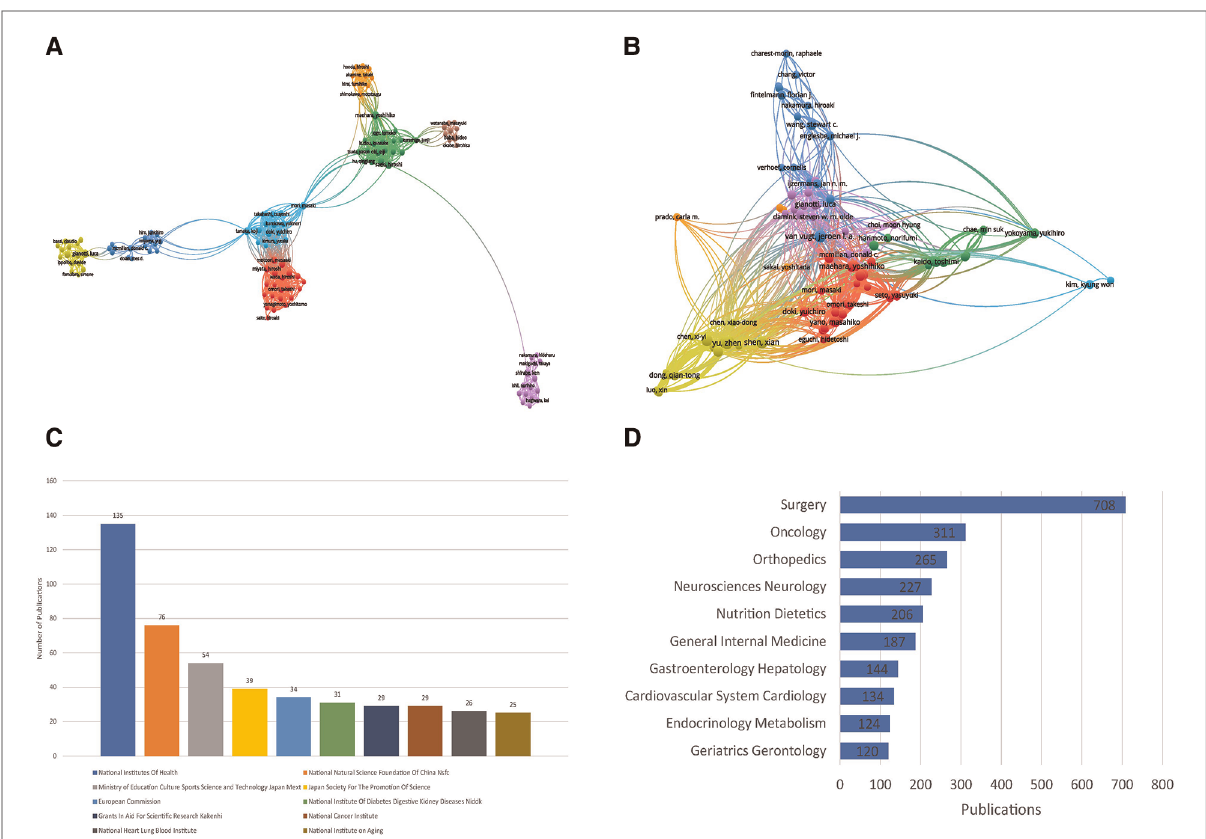
FIGURE 3 Information of authors, funding agencies, and research directions: ( A ) Map of collaborative relationships between authors: the size of nodes represents the number of publications and the line means their collaborative relationship; ( B ) Map of cited relationships between authors: the size of nodes represents the number of citations and the line means their citation relationship; ( C ) Distribution of the top 10 funding agencies; ( D ) The information of top 10 research